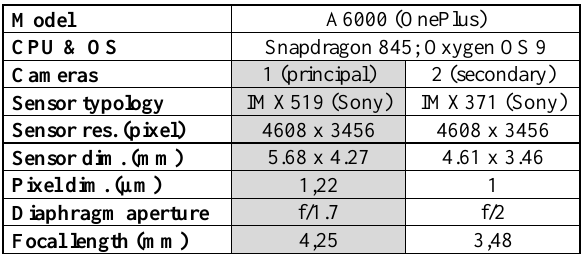
Table 1. General smartphone parameters.